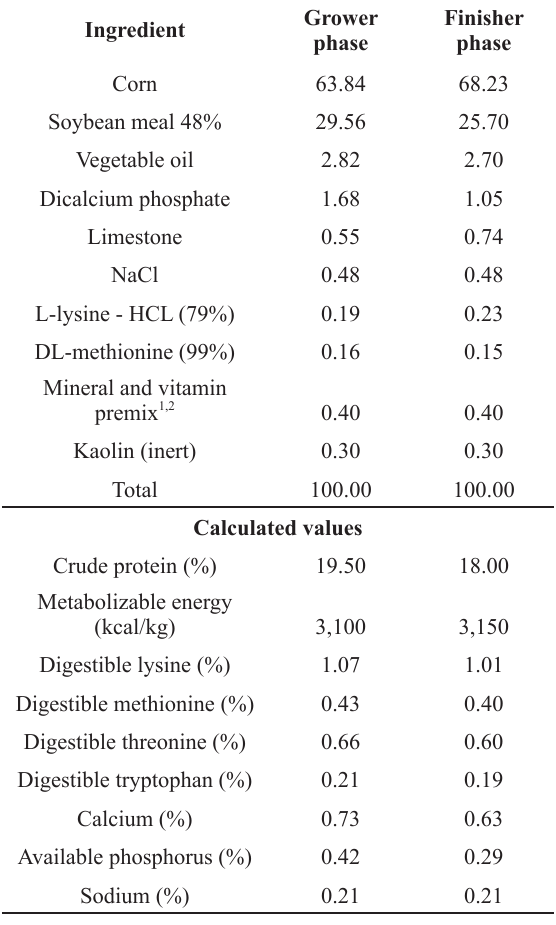
Experimental diets for broilers in the grower (22 to 33 days) and finisher (34 to 42 days old)